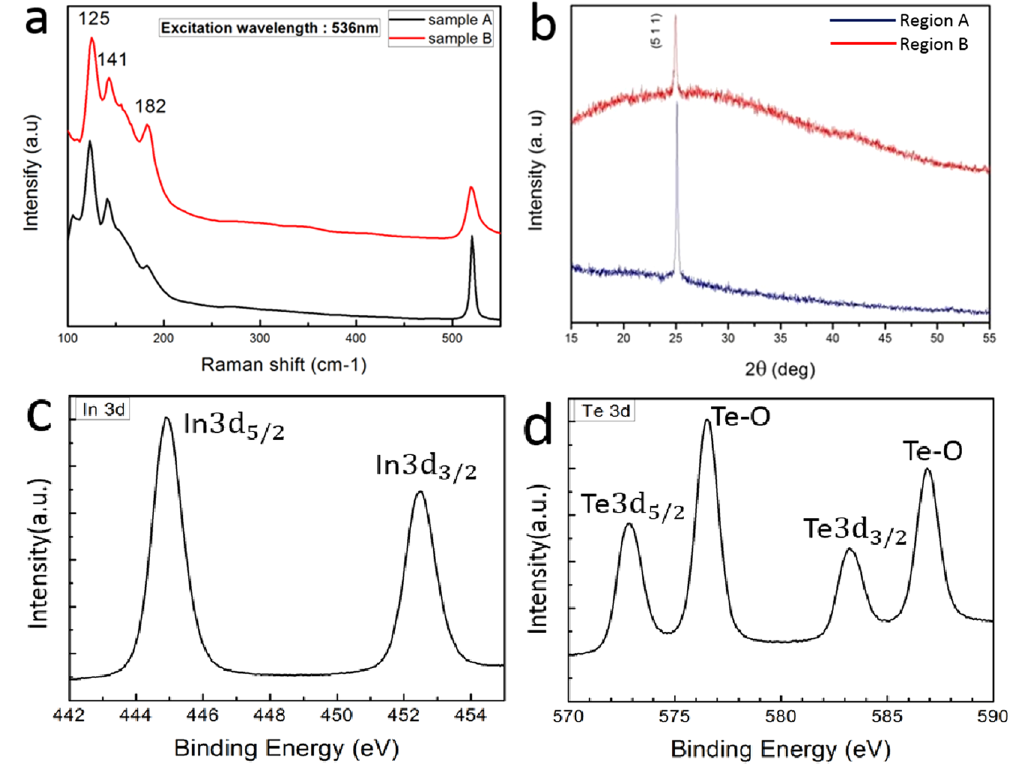
Figure 2. ( a ) Raman spectra from two different few-layer α -In 2 Te 3 both with typical three Raman peaks at 125, 141 and 182 cm − 1 ; ( b ) X-ray diffraction result from a typical α -In 2 Te 3 film from different spots in the same sample. XPS spectra of ( c ) In 3d and ( d ) Te 3d levels in few-layer α -In 2 Te 3